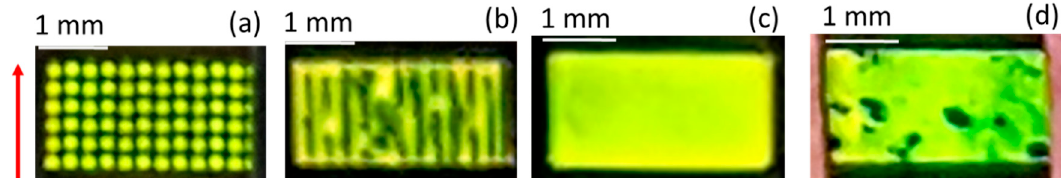
Figure 4. Light emission from PLEDs, where Cs 2 CO 3 film was printed with various resolutions ( a ) 100 dpi ( b ) 200 dpi ( c ) 300 dpi to 600 dpi ( d ) 700 dpi and 800 dpi. Red arrow on the left side shows the printing direction (vertically up).